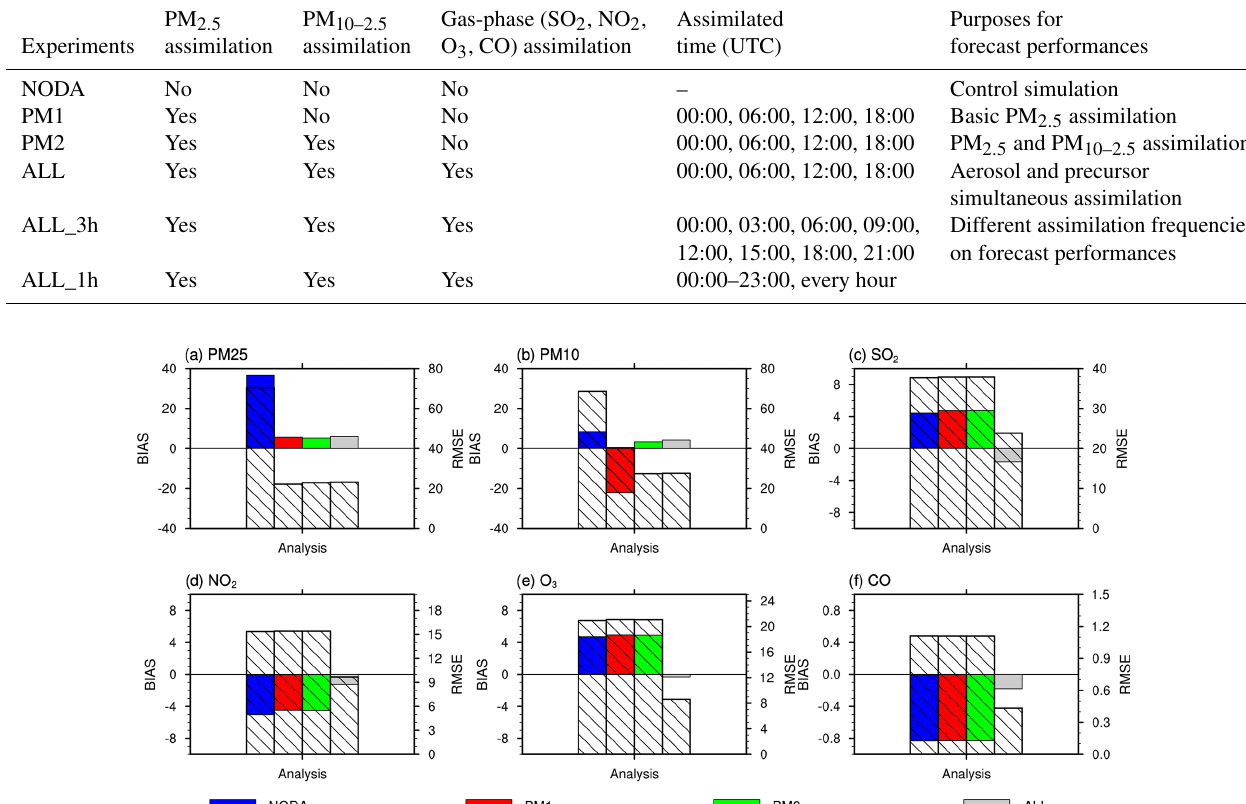
Table 2. Detailed setting of six experiments and their purposes.